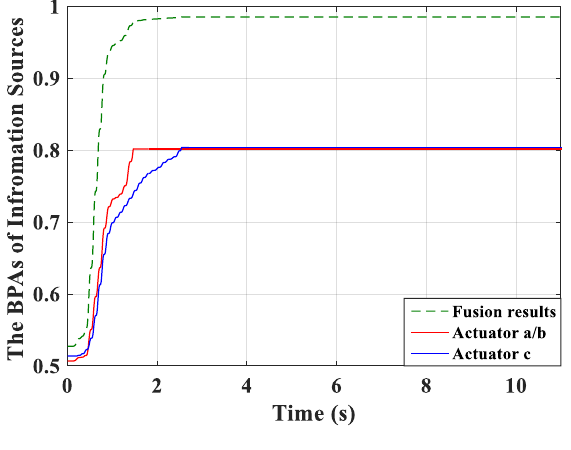
Figure 14. The BPAs curves.